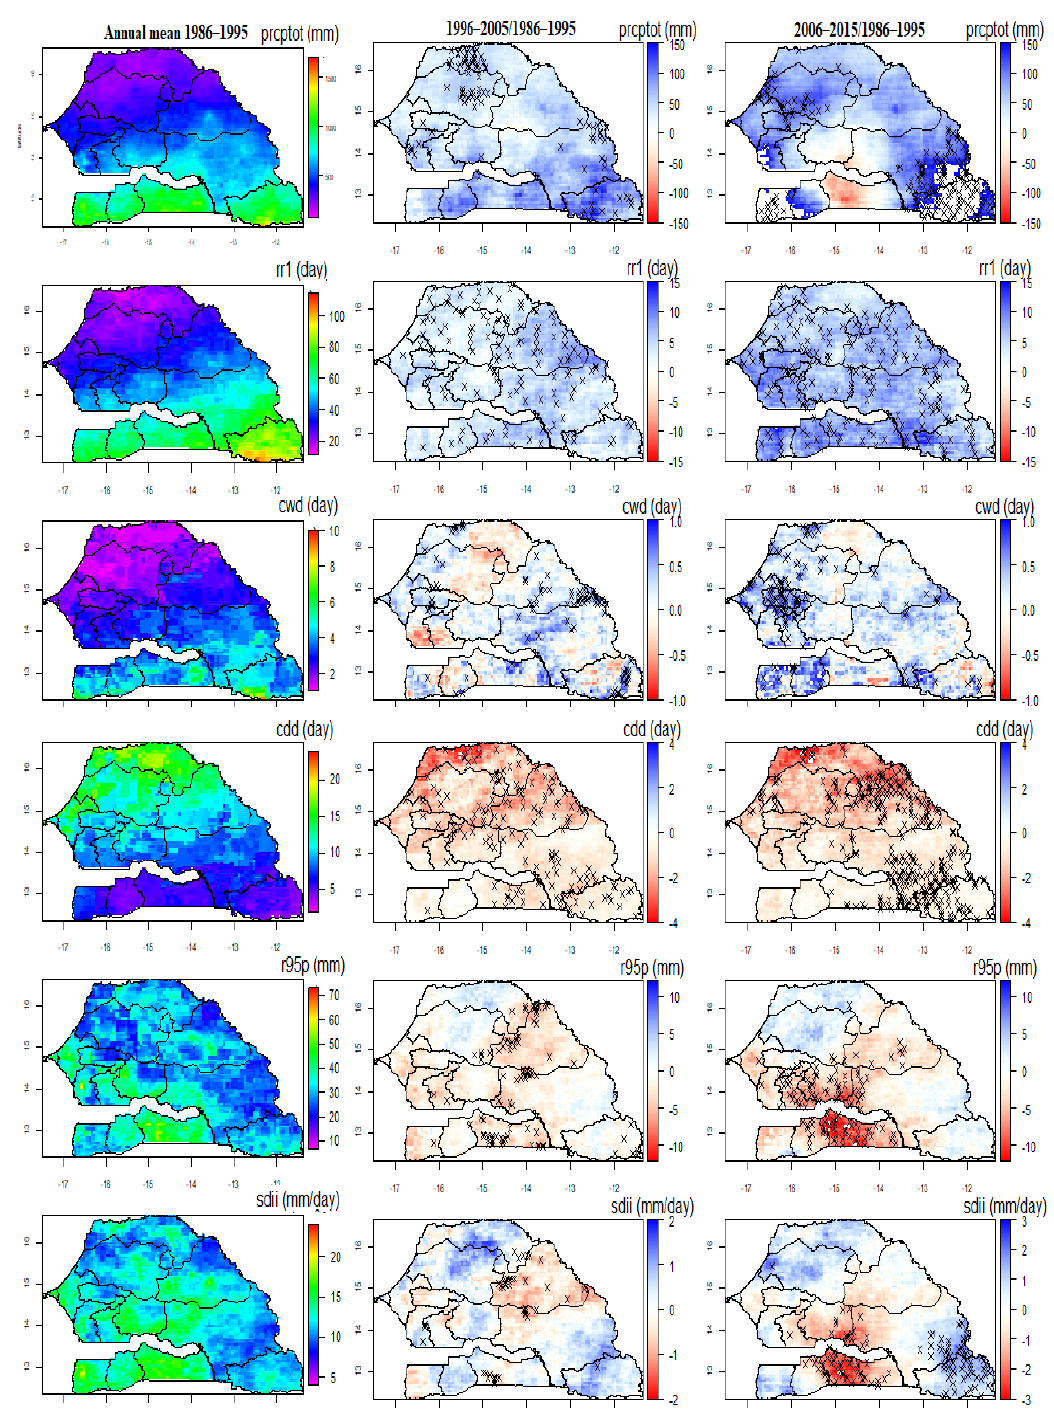
Figure 7. Spatial patterns of precipitation indices over Senegal: mean over the reference decade 1986–1995 (first column); change over the 1996–2005 decade (second column) and changes over the 2006–2015 decade relative to the reference decade (third column). Areas with symbol (x) are significant at a 95% confidence level.